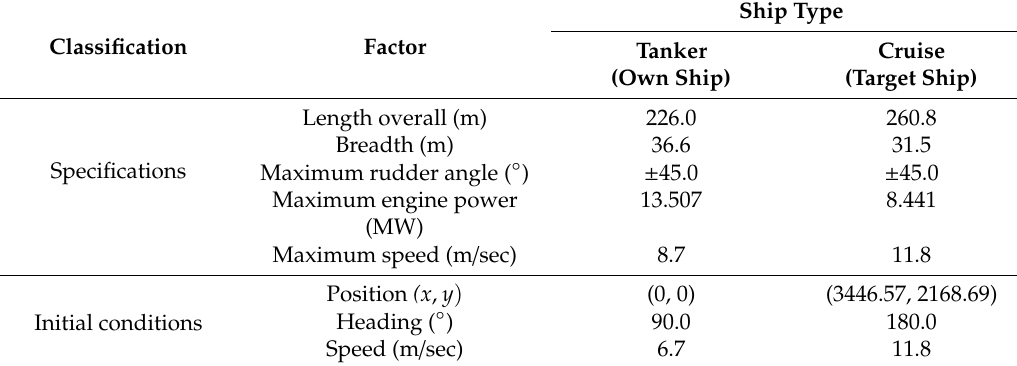
Figure 4. Simulation scenarios where collision avoidance action is required. Table 1. Specifications and initial conditions of ships used in the simulations.